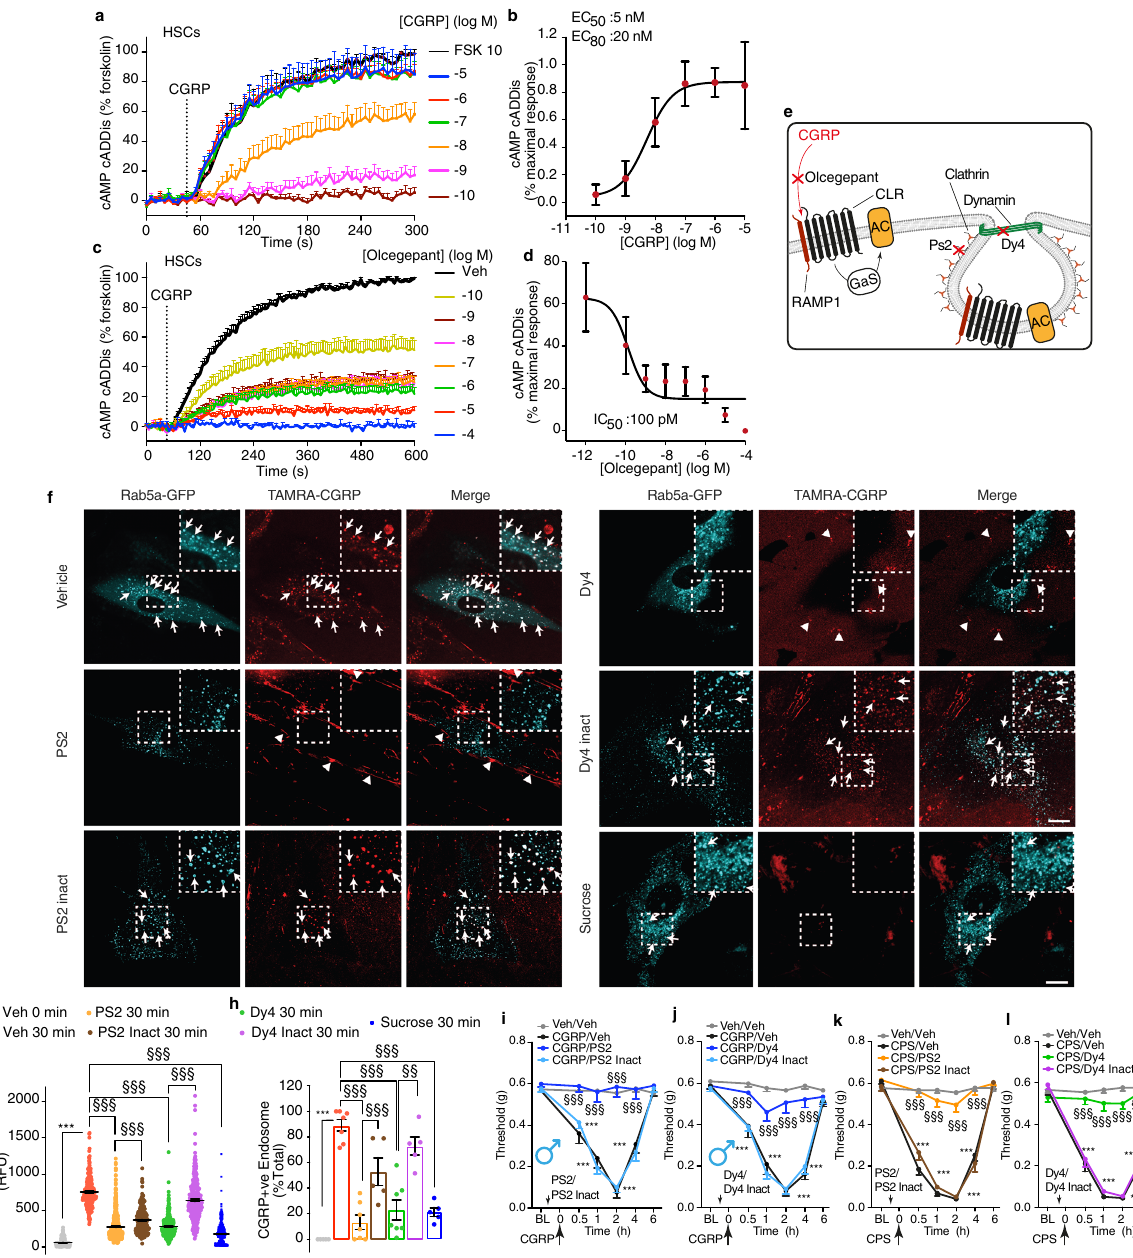
Fig. 4 Functional CLR/RAMP1 is expressed by HSCs and undergoes clathrin- and dynamin-mediated endocytosis, which underlies nociception. a , b Effects of graded concentrations of CGRP on cAMP formation ( n = 5 independent experiments). c , d Effects of graded concentrations of olcegepant on CGRP (100 nM)-evoked cAMP formation ( n = 4 independent experiments). e Pharmacological targets. f Representative images of HSCs expressing Rab5a- GFP at 30 min after incubation with TAMRA-CGRP (100 nM). Arrows denote colocalization of TAMRA-CGRP and Rab5a-GFP. Arrowheads denote retention of a weak TAMRA-CGRP signal at the plasma membrane. Cells were preincubated with vehicle, Dyngo-4a (Dy4), Pitstop 2 (PS2), inactive analogs (PS2 and Dy4 inact) (all 30 µ M) or sucrose (0.45 M) ( n = 4 independent experiments). Scale, 10 µ m. g Quanti fi cation of localization of TAMRA- CGRP in endosomes (data represent n = 949 veh 0 min, n = 1209 veh 30 min, n = 1111 Dy4 30 min, n = 1016 Dy4 inact 30 min, n = 1700 PS2 30 min, n = 714 PS2 inact 30 min, n = 1896 sucrose) and ( h ) quanti fi cation of the number of TAMRA-CGRP + ve endosomes (data represent n = 5 veh 0 min, n = 7 veh 30 min, n = 7 Dy4 30 min, n = 5 Dy4 inact 30 min, n = 7 PS2 30 min, n = 5 PS2 inact 30 min, n = 5 sucrose). i , j PMA induced by periorbital CGRP (1.5 nmol) or vehicle in C57BL/6 J male mice pretreated (0.5 h) with PS2, Dy4, PS2 or Dy4 inact (all 500 pmol) ( n = 8 mice per group). k , l PMA induced by periorbital capsaicin (CPS, 50 pmol) or vehicle in C57BL/6 J male mice pretreated (0.5 h) with PS2, Dy4, PS2 or Dy4 inact (all 500 pmol) ( n = 8 mice per group). Mean±SEM. *** P < 0.001 vs. Veh 0 min, and Veh/Veh; §§ P < 0.01, §§§ P < 0.001 vs. Veh 30 min, PS2 30 min, Dy4 30 min, CGRP/PS2 inact, CGRP/ Dy4 inact, CPS/PS2 inact, CPS/Dy4 inact. 1-way ( g , h ) or 2-way ( i – l ) ANOVA, Bonferroni correction. Source data are provided as a Source Data fi le.